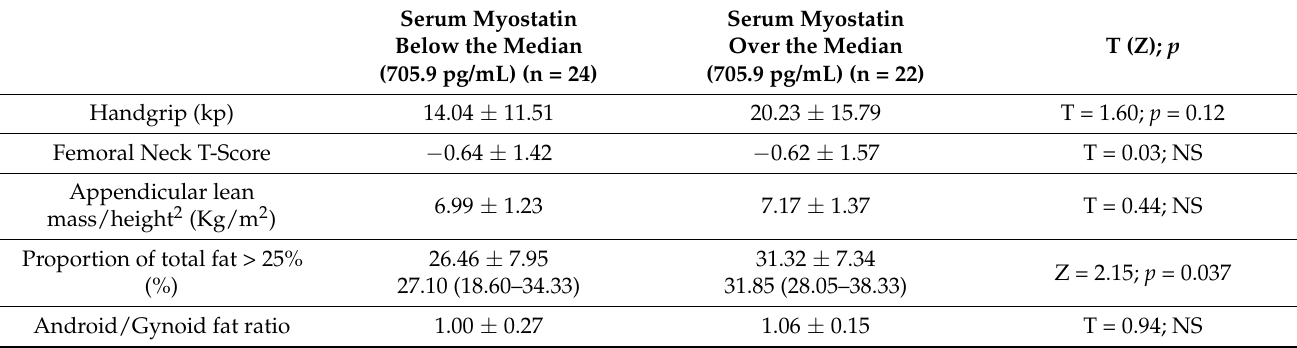
Table 4. Relationships between serum myostatin and OSA